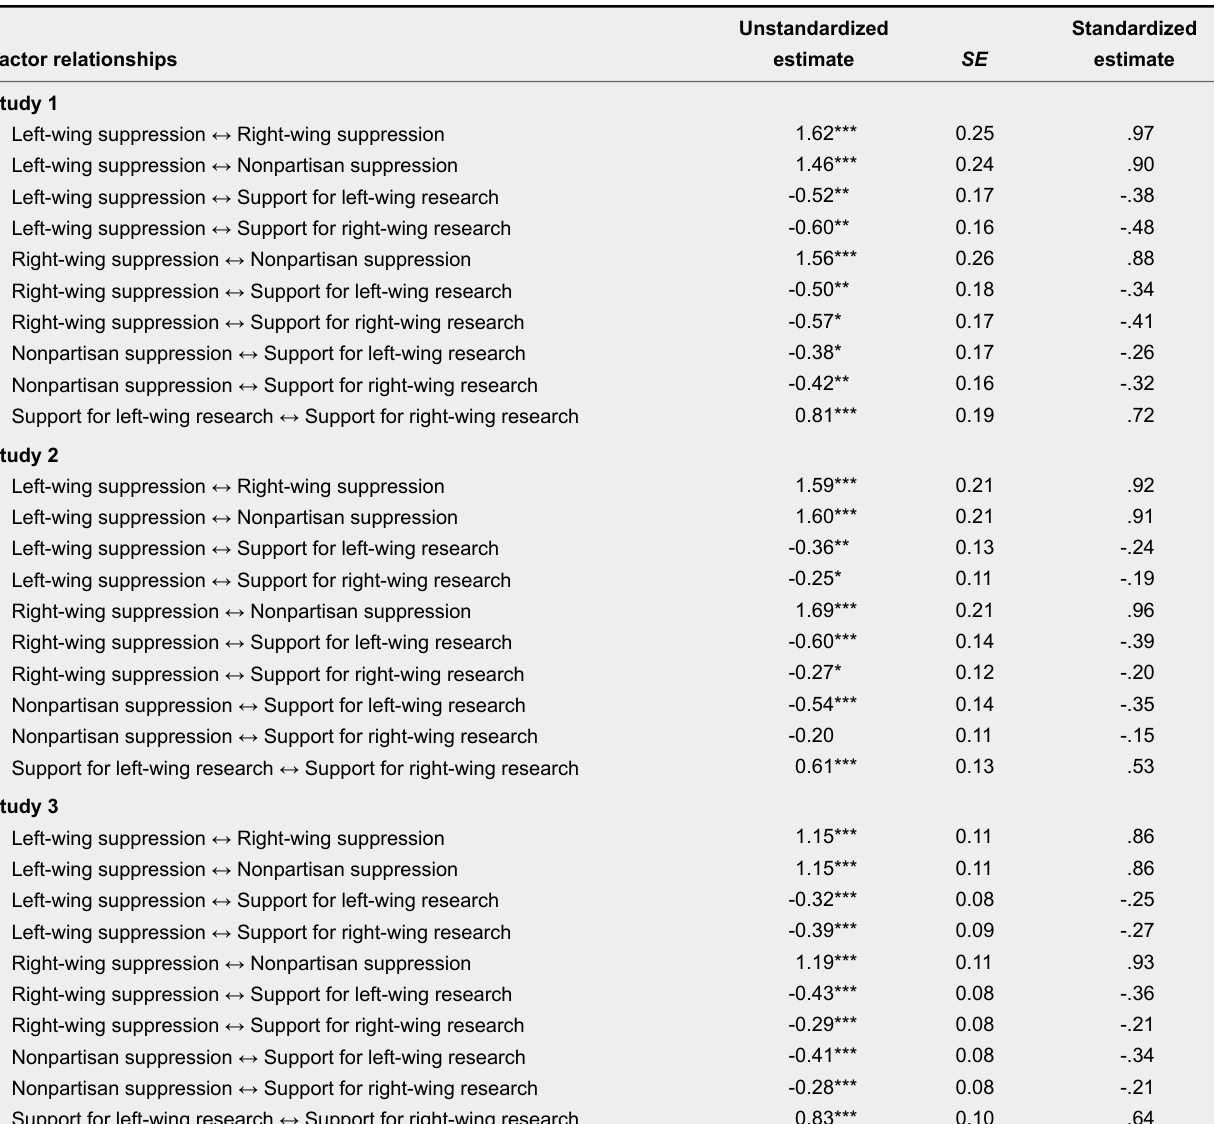
Parameter Estimates for Full Predicted Five-Factor